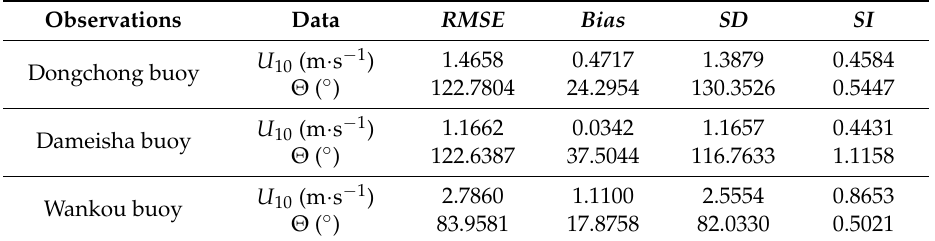
Table 8. Summary of the error indicators for the simulations from 29 August to 5 September